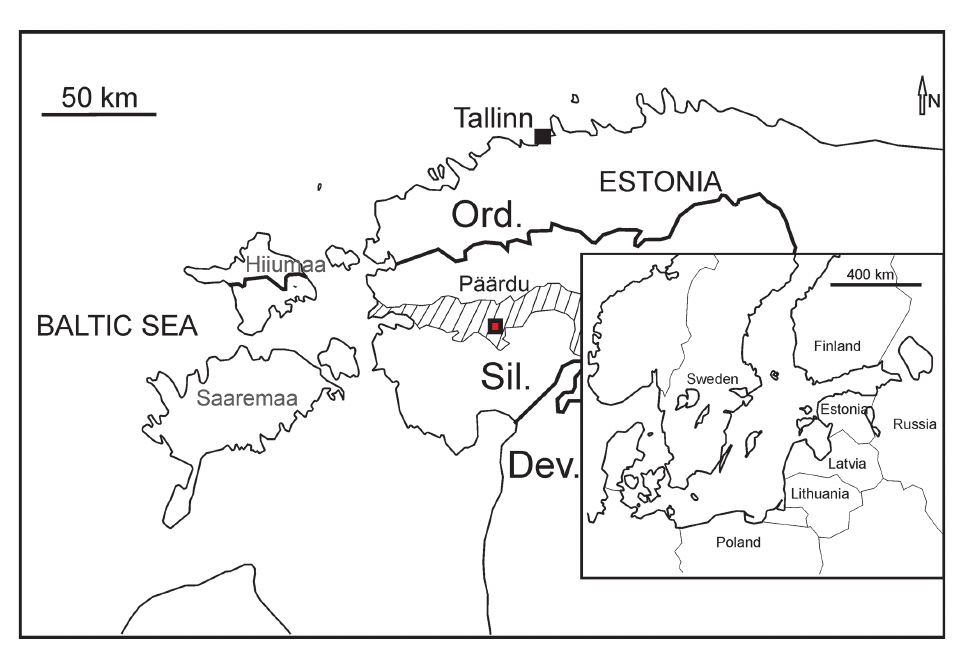
Fig. 1. Location of the Päärdu outcrop at the Velise River, western Estonia. Exposure of the Adavere Regional Stage (incl. Rumba Formation) is marked with slanting lines.